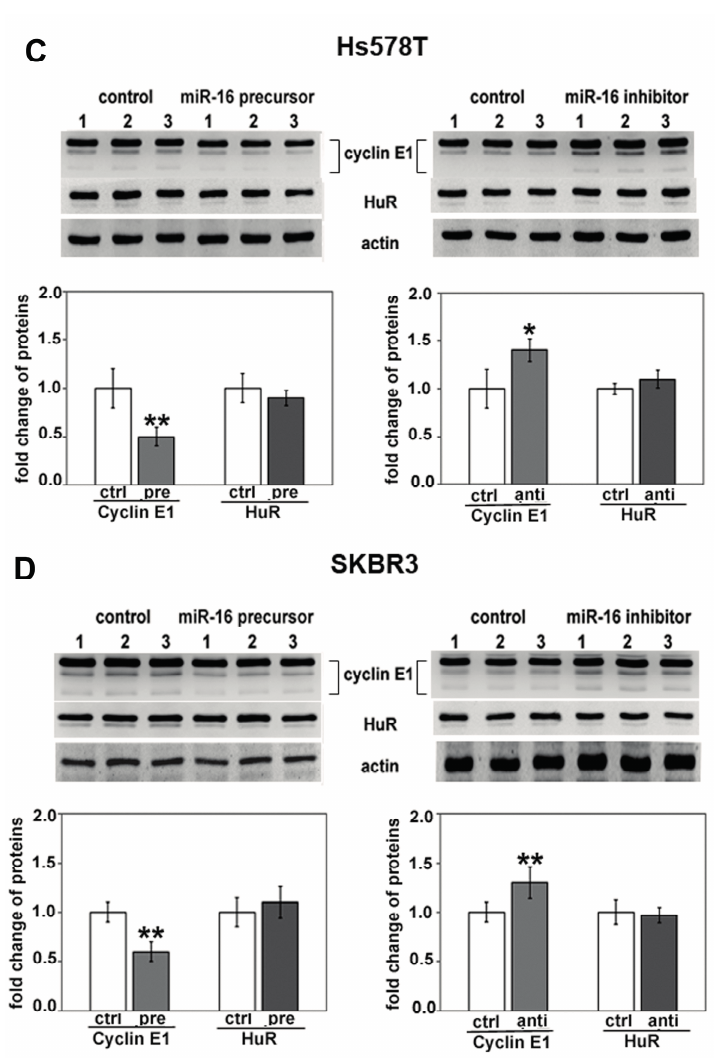
Figure 2. miR-16 regulates cyclin E1 in breast cancer cells. ( A ) Northern analysis of miR-16 level in a nontumorigenic breast epithelial cell line (MCF10A) and three different breast cancer cell lines (MCF7, SKBR3, and Hs578T). Blot was reprobed for U6 snRNA. Bottom numbers are density relative to MCF10A cells after normalization to U6 snRNA; ( B – D ) The indicated breast cancer cell lines were transfected with control miRNA (ctrl), miR-16 precursor (pre) or antagomir (anti). The level of cyclin E1, HuR and loading control actin were assessed by western blot analysis ( top ). Numbers 1–3 represent three separate experiments. Cyclin E1 and HuR western blot signals were quantified by densitometry ( bottom ). Values are the means ± SD from three independent